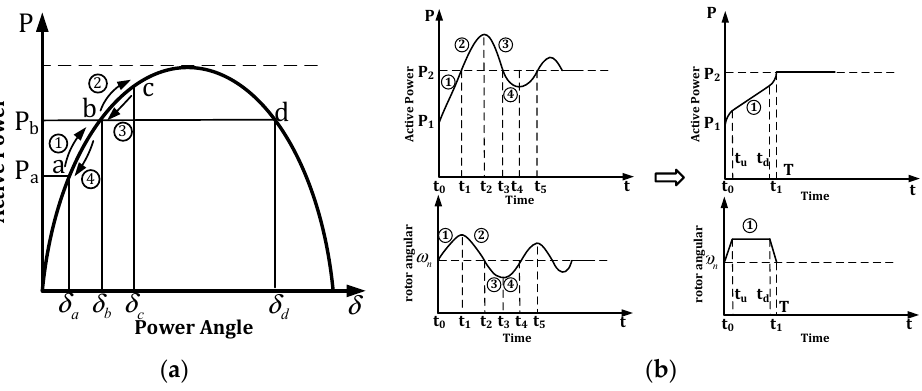
Figure 4. The power-angle curve of a synchronous machine (SM) and the proposed VSG: ( a ) the SM response during transient disturbances; ( b ) the proposed VSG response during transient disturbances.